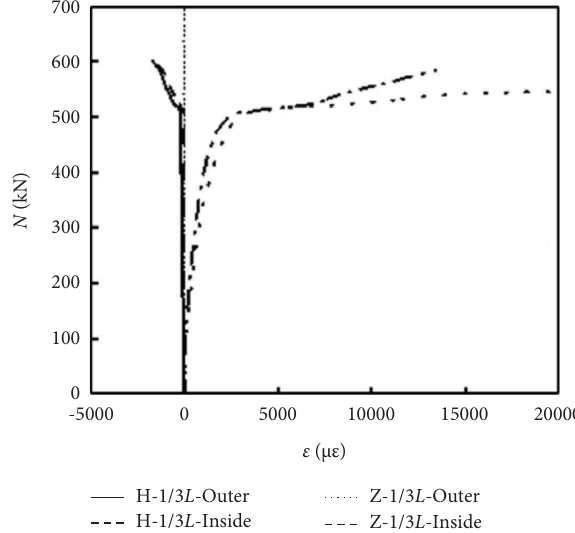
Figure 13: Strain comparison of inner and outer wall of steel